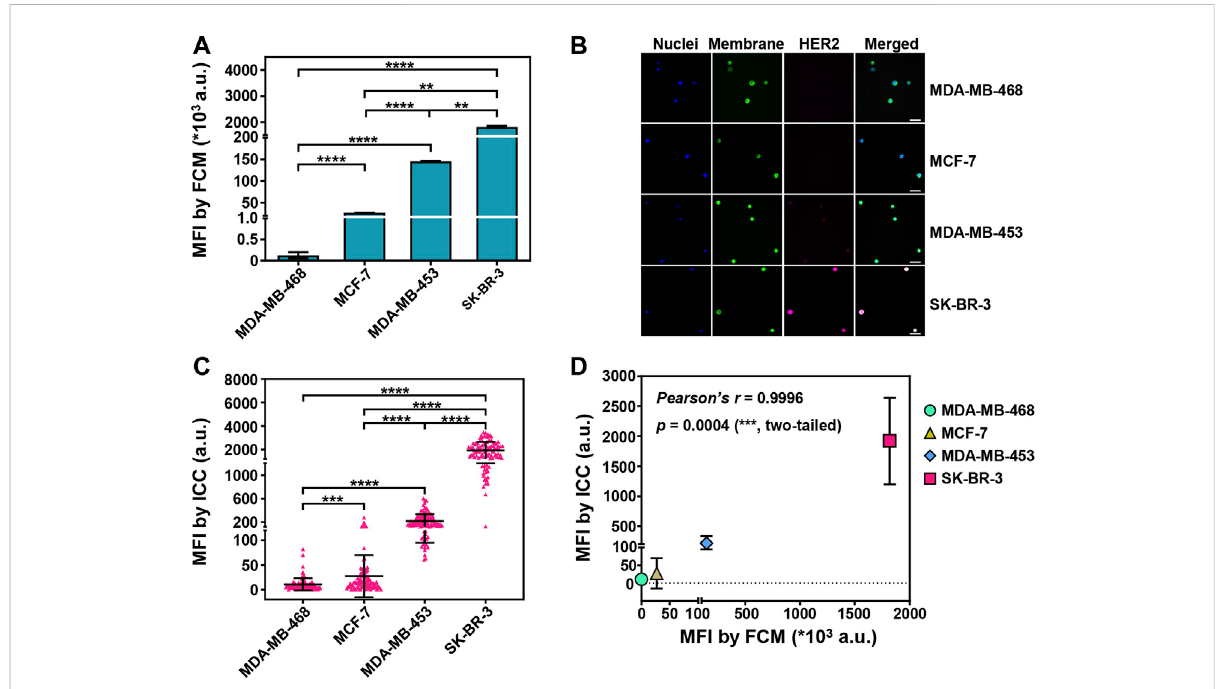
FIGURE 1 Sensitive detection of HER2 expression on captured breast cancer cells by ICC. (A) The mean fl uorescent intensities (MFIs) of PE-labeled anti- HER2 on four breast cancer cell lines (SK-BR-3, MDA-MB-453, MCF-7, MDA-MB-468) from fl ow cytometry (FCM) analysis. Data are presented as means ± SD from 3 parallel samples. ** p < 0.01, **** p < 0.0001, unpaired Student ’ s t -test. (B) Fluorescent images of the isolated breast cancer cells. The cancer cells were pre-stained with DAPI (blue, nuclei) and DiO (green, membrane), and then the isolated cancer cells were stained with Alexa Fluor 647-conjugated anti-HER2 (pink, HER2). Scale bar: 50 μ m. (C) The MFIs from HER2 immunostaining on the captured breast cancer cells by Pep@MNPs in System 1 (1,000 breast cancer cells/1 ml PBS). Data are presented as scattered dots from 100 events, together with means ± SD. **** p < 0.0001, *** p < 0.001, unpaired Student ’ s t -test with Welch ’ s correction. (D) Correlation analysis between the MFIs from HER2 immunostaining on four breast cancer cell lines by ICC and by FCM. Pearson ’ s correlation coef fi cient r = 0.9996, with a signi fi cant p value (0.0004, ***,